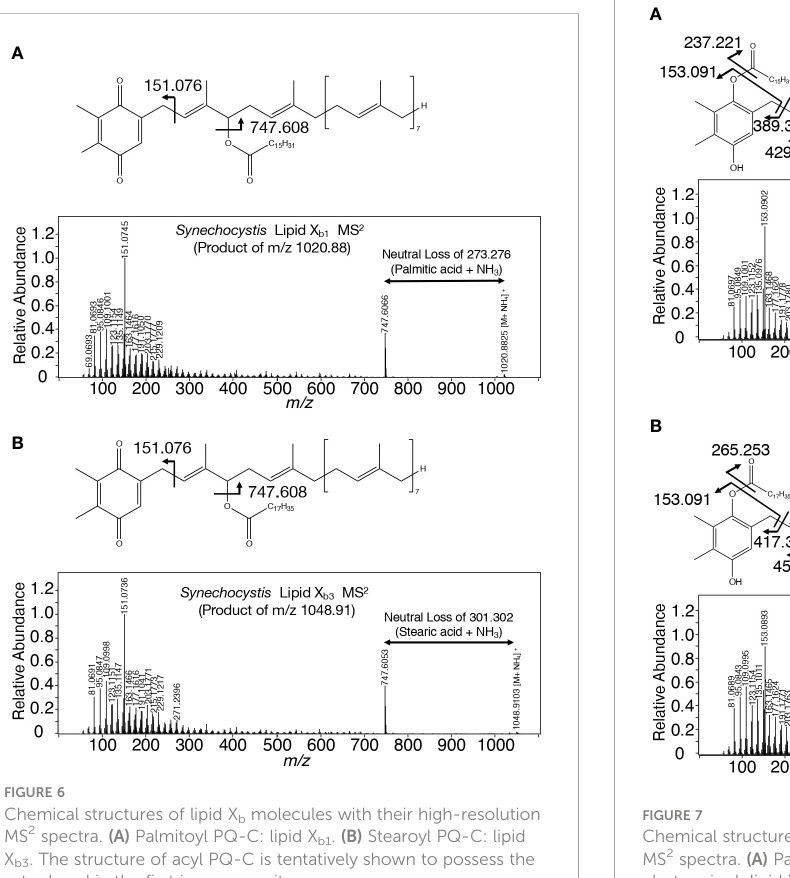
FIGURE 6 Chemical structures of lipid X b molecules with their high-resolution MS 2 spectra. (A) Palmitoyl PQ-C: lipid X b1 . (B) Stearoyl PQ-C: lipid X b3 . The structure of acyl PQ-C is tentatively shown to possess the ester bond in the fi rst isoprene unit.